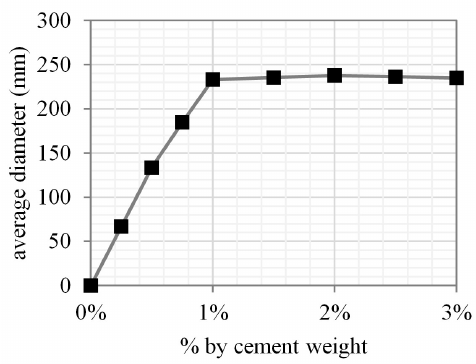
Figure 2. Superplasticizer saturation dosage test